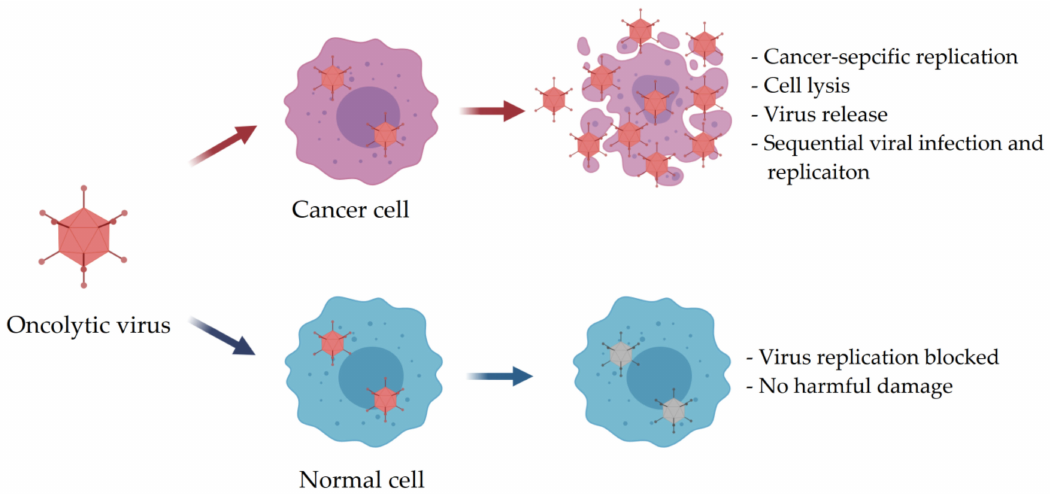
Figure 1. Schematic diagram of cancer cell-specific killing of oncolytic viruses (OVs) (Modified from